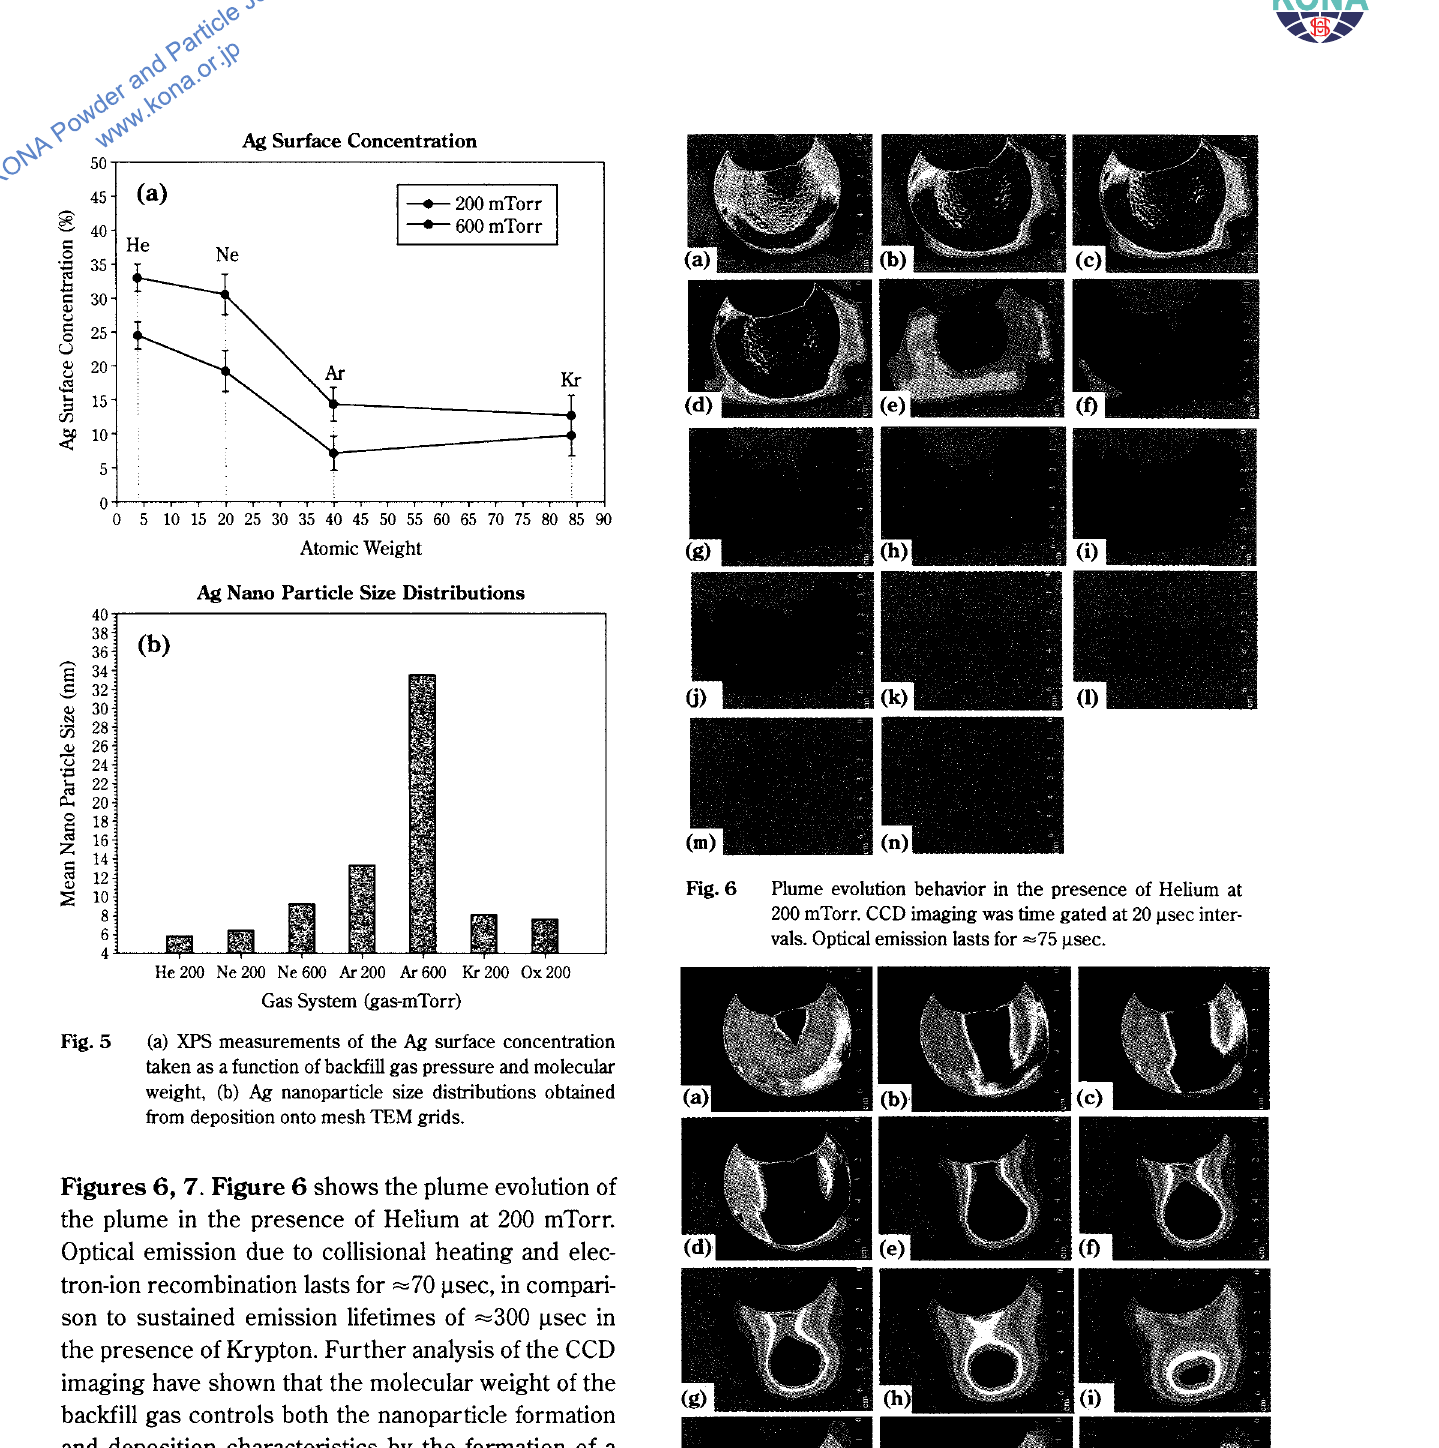
Fig. 5 (a) XPS measurements of the Ag surface concentration taken as a function of backfill gas pressure and molecular weight, (b) Ag nanoparticle size distributions obtained from deposition onto mesh TEM grids.